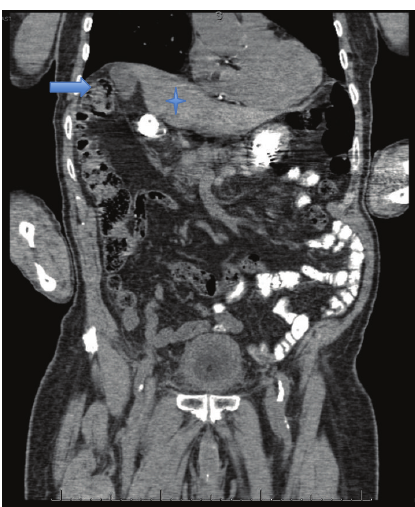
Figure 2: CT of the abdomen (coronal section) showing loops of colon (arrow) between the liver (asterisk) and the right hemidi-